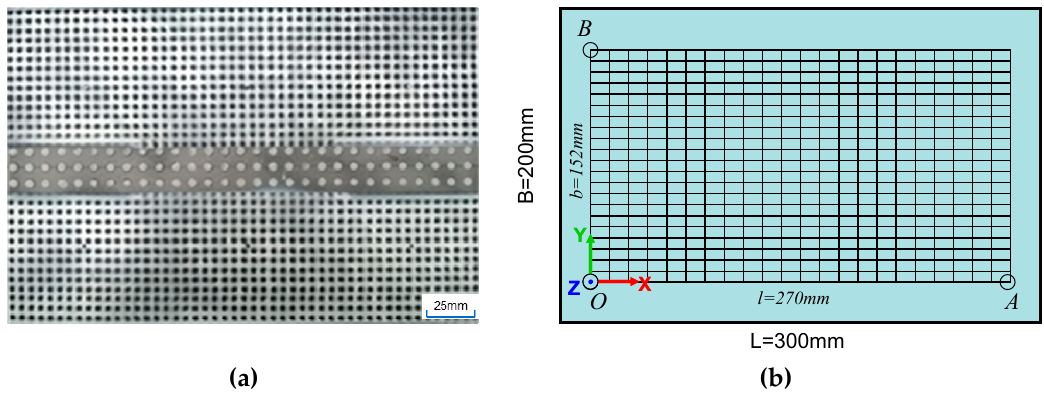
Figure 2. Distortion measurement by the digital image correlation (DIC) technique. ( a ) speckle paint on plate back side, ( b ) point grid for data extraction.